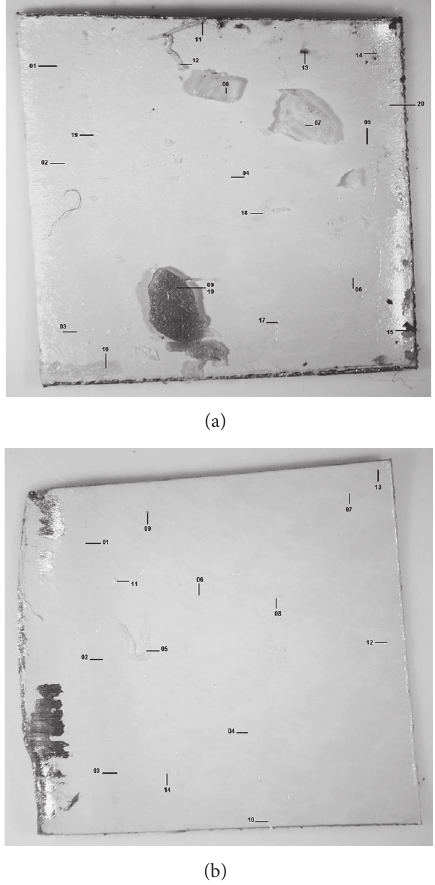
Figure 5: (a) Sample M1 of PET-coated ECCS plate showing zones of salmon muscle adhesion; numbers indicate points of spectral analyses. (b) Layout of points for spectral analyses in urea-treated sample